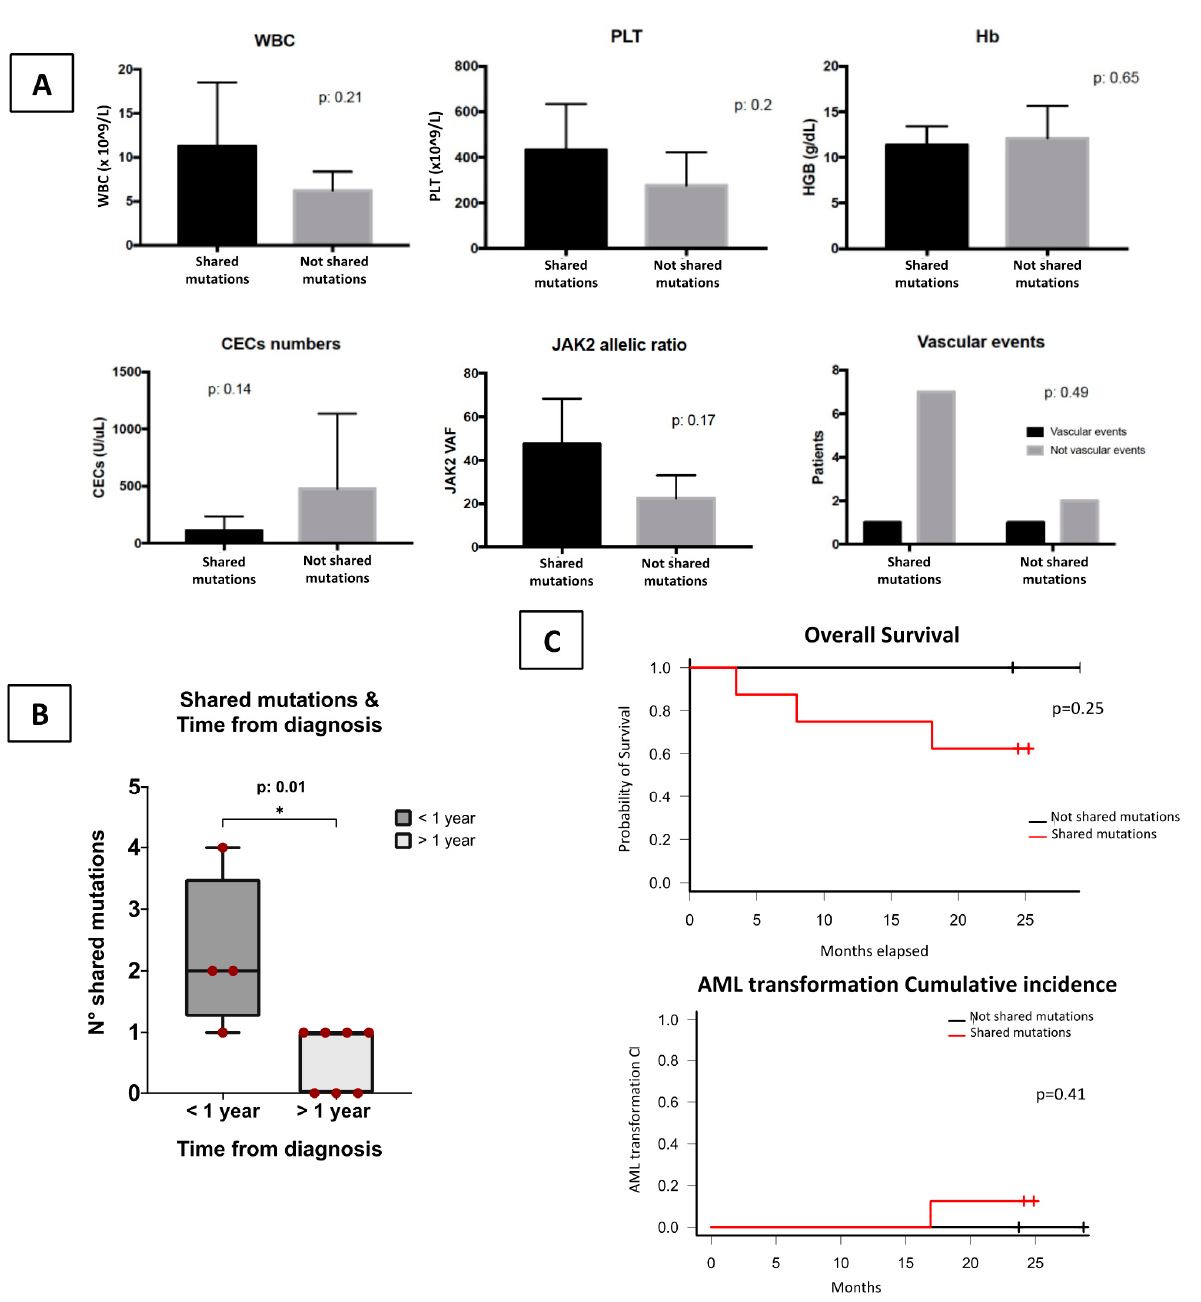
Figure 5. CECs Molecular profile and Clinical correlations. ( A ) No significative clinical or biological differences at baseline were found between patients who shared mutations between HSPCs and CECs and those who did not. ( B ) Number of shared mutations between CECs and HSPCs, according to the time from diagnosis. Patients collected within 1 year from PMF diagnosis shared an higher number of mutations between the two subpopulations compared with patients collected after 1 year ( p = 0.01) ( C ) The presence of shared mutations not impact in clinical outcome of the PMF patients during the follow up (neither overall survival or Acute myeloid transformation cumulative incidence). Notably, all the patients who did not share any mutations between HSPCs and CECs are all still alive at the time of the analysis. WBC = White blood count; PLT = Platelets; Hb = Hemoglobin; CEC = Circulating endothelial cells; VAF = variant allele frequency; AML = Acute myeloid leukemia. * p < 0.05.